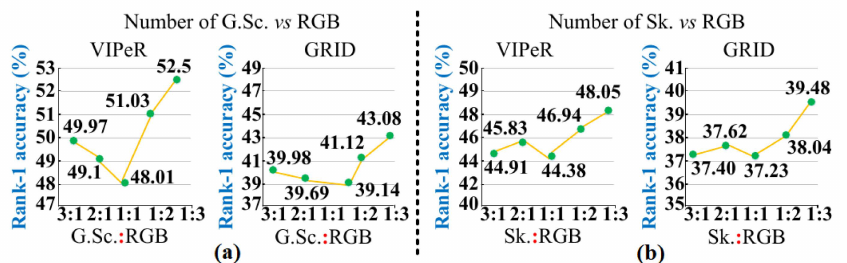
Figure 13. Rank-1 Result Comparison for Different Representation Ratios on VIPeR & GRID for ( a ) G.Sc. vs. RGB ( b ) Sk. vs.